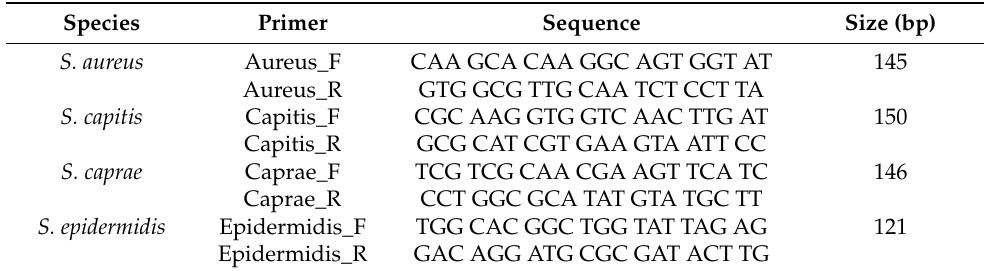
Table 2. Specific primer